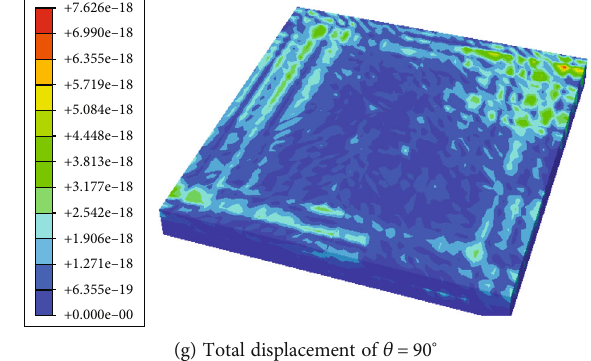
Figure 6: Displacement nephogram of the model under di ff erent perforation angles after in situ stress